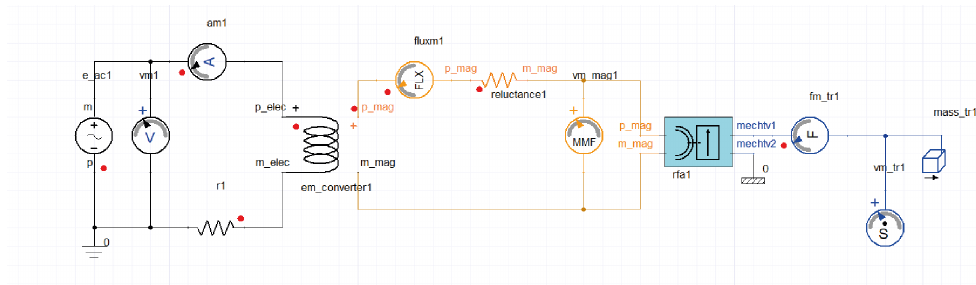
Figure 5. Twin Builder